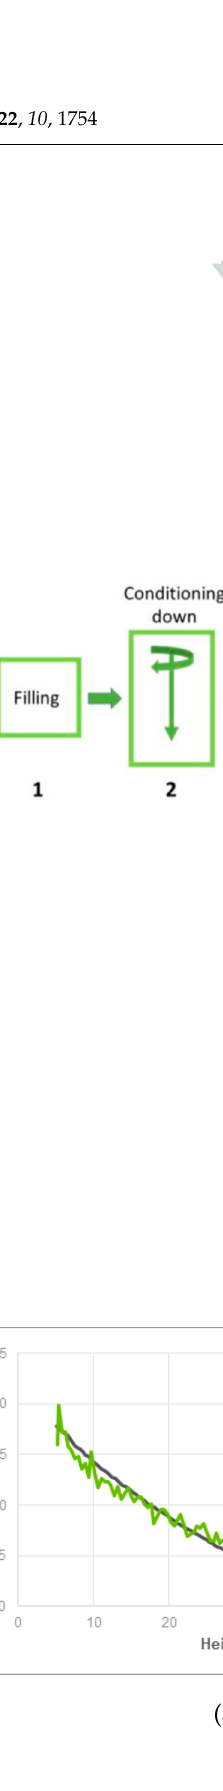
( b ) Figure 5. Experimental and basic flow energies at 100 mm/s blade-tip speed for ( a ) free-flowing powder and ( b ) cohesive powder. 2.3. DEM Modeling of the Dosing Wheel Application The filling and kinematics of the physical system were fully replicated in the DEM model, as shown in Figure 6. This involved the filling of the doser under gravity, followed by the discharge of the powder by the rotation of the dosing wheel onto a vibrating sur- face. Approximately 1.2 × 10 5 bi-sphered particles were generated by the random rainfall method and were allowed to settle under gravity until a static powder bed was achieved. The dosing process was then simulated for 22 s of physical time. A graphic processing unit was used to accelerate the calculations.